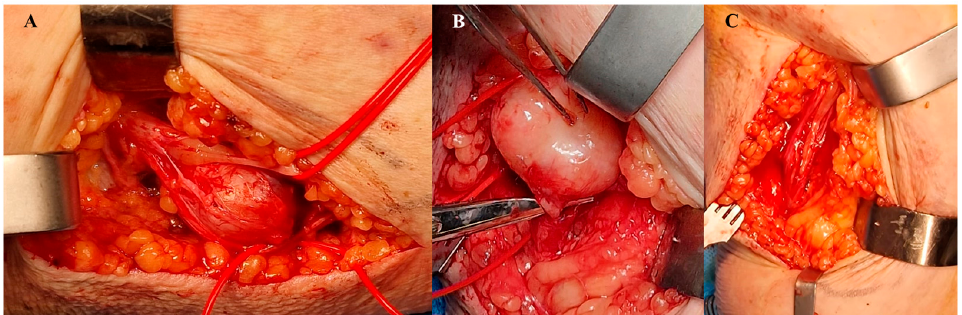
Figure 6 . Schwannoma ( A ) intraoperative aspect, ( B ) intraoperative detail, ( C ) nerve after schwannoma ablation .